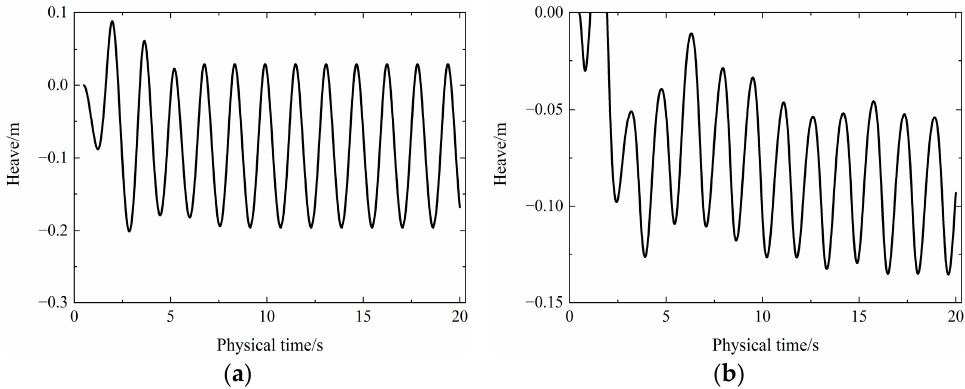
Figure 23. The time history curve of heave amplitude under case 7: ( a ) monohull; ( b ) pentamaran.